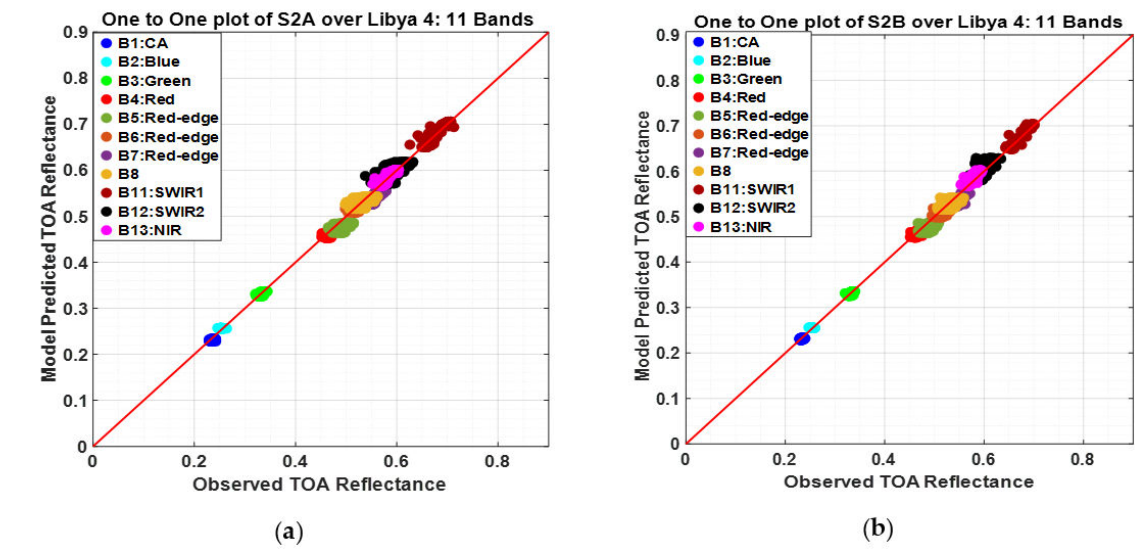
Figure 12. Comparison of the hyperspectral APICS model predicted TOA reflectance and the corresponding observed ( a ) S2A MSI bands; ( b ) S2B MSI bands. Red solid is the reference line. Table 7 exhibits the summarized results of mean absolute percentage difference,